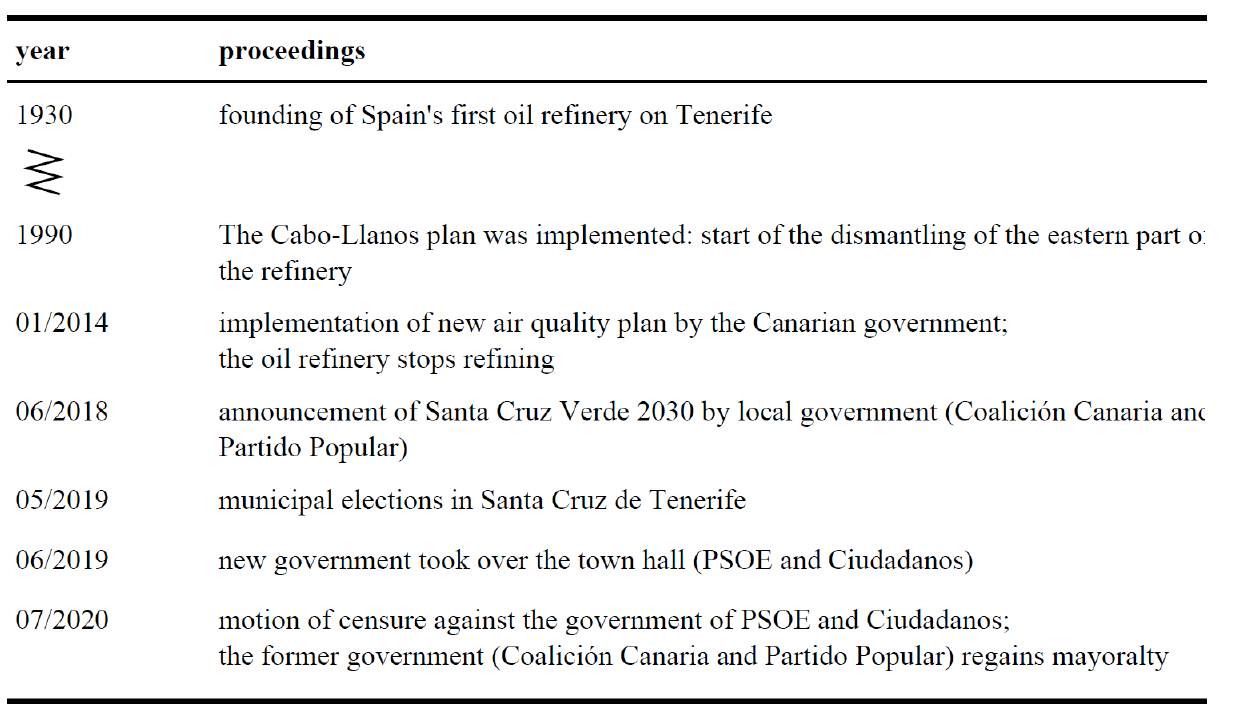
Figure 3. The history of the oil refinery “Tenerife” in Santa Cruz de Tenerife and current politics. Own elaboration based on Arencibia de Torres [41], Gobierno de Canarias [47] and Santa Cruz de Tenerife Ayuntamiento [4].